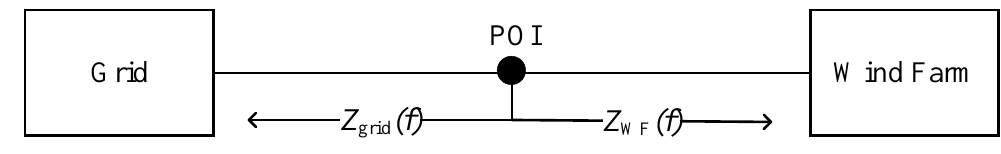
Figure 4. Illustration of frequency scan system